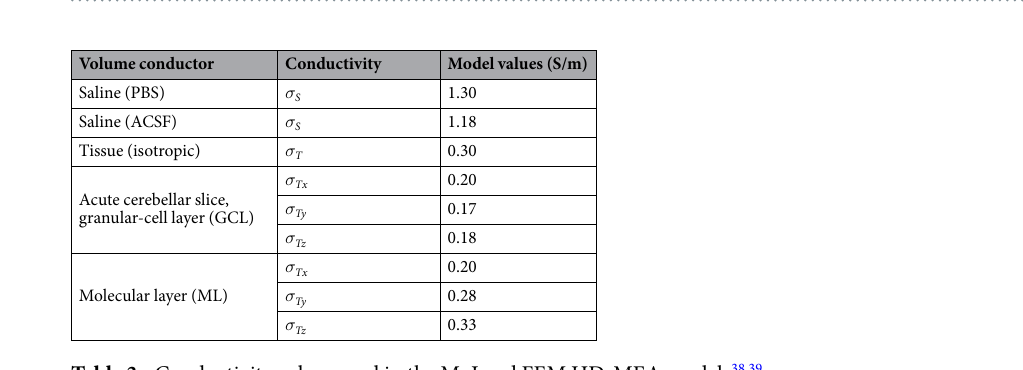
Table 3. Conductivity values used in the MoI and FEM HD-MEA models 38,39